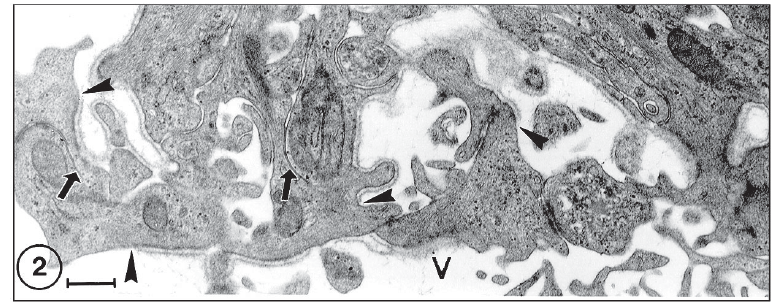
Figure 2. High power view of a glial tuft abutting the vitreous body (V). Bar = 0.5 µm. Note gap junctions (arrows) and discontinuities of the basement membrane around the astro- cytes